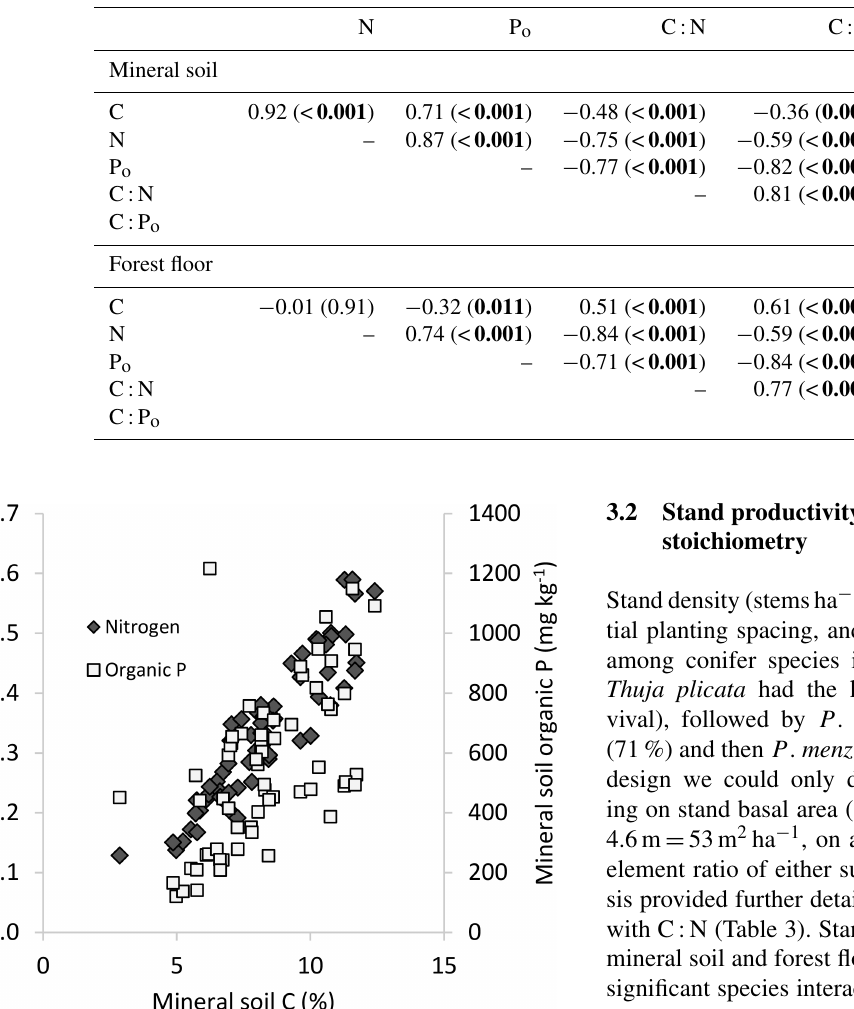
Table 2. Pearson correlation r and p values (in brackets, <0.05 in bold) among total C, N, P o concentrations and associated molar element ratios of the mineral soil (0–20cm) and forest floor.